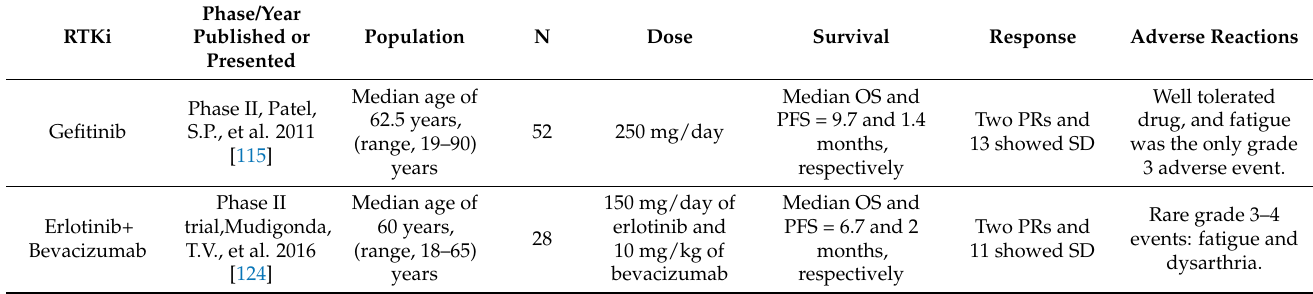
Table 7. EGFR inhibitors evaluated in different melanoma clinical